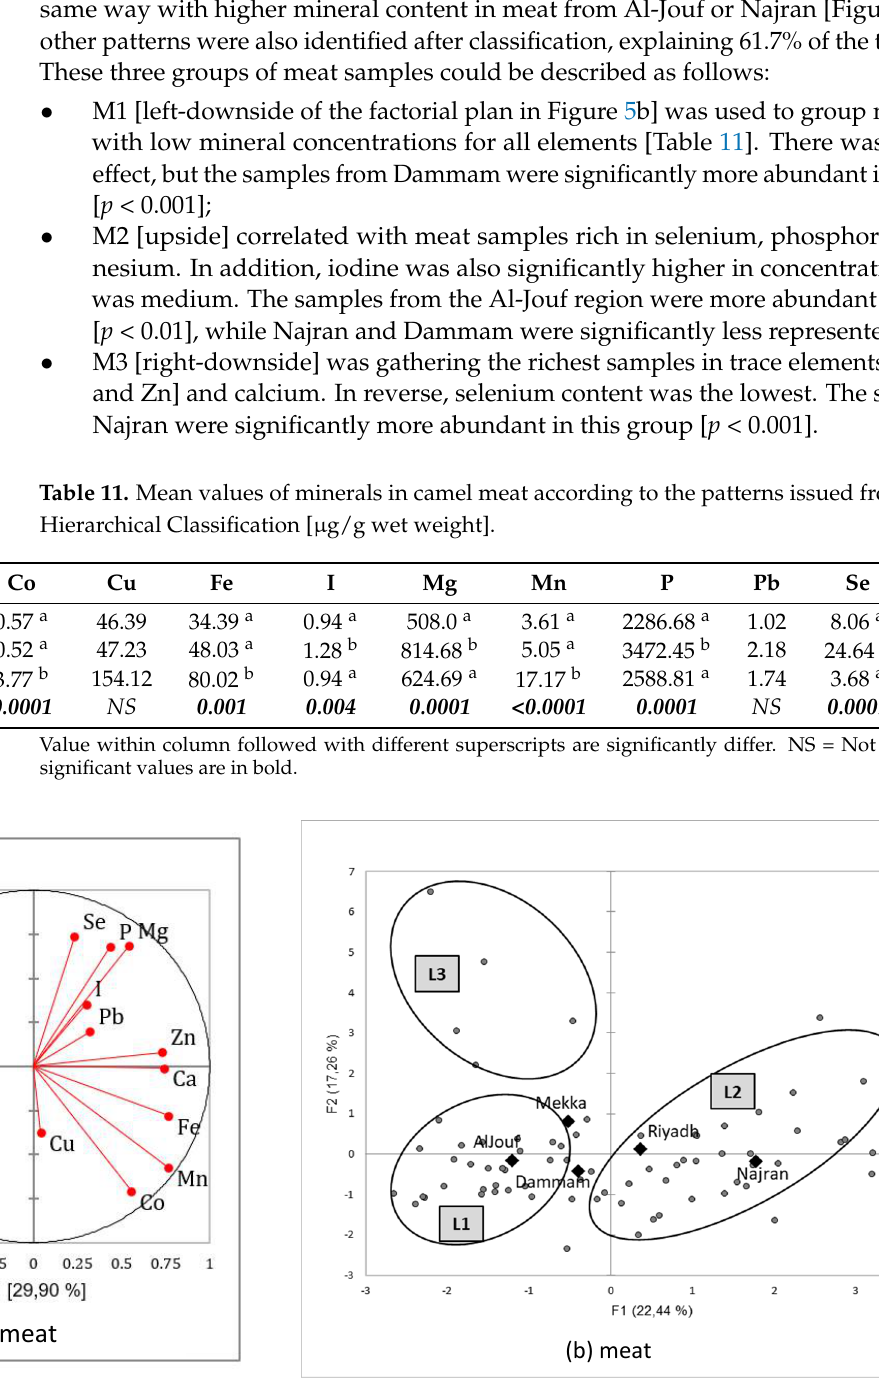
Figure 5. Correlation circles ( a ) for the two first factors of the Principal Components Analysis showing the relationships between minerals in camel meat, and main factorial plan ( b ) with representation of the three mineral patterns of the meat sampled in Saudi slaughterhouses from five regions and at two seasons (squares represents the mean value for each region and dots the different meat sample values) Table 11. Mean values of minerals in camel meat according to the patterns issued from Ascending Hierarchical Classification [µg/g wet weight].